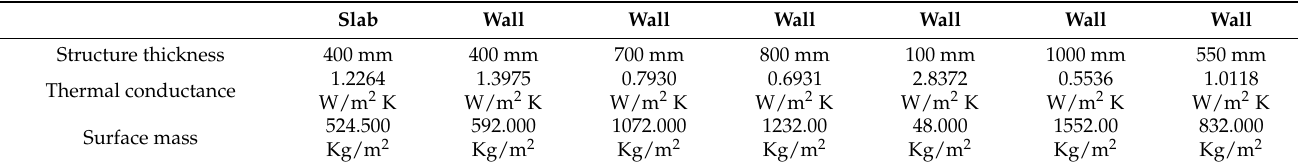
Table 3. Thermal conductivity analysis of the